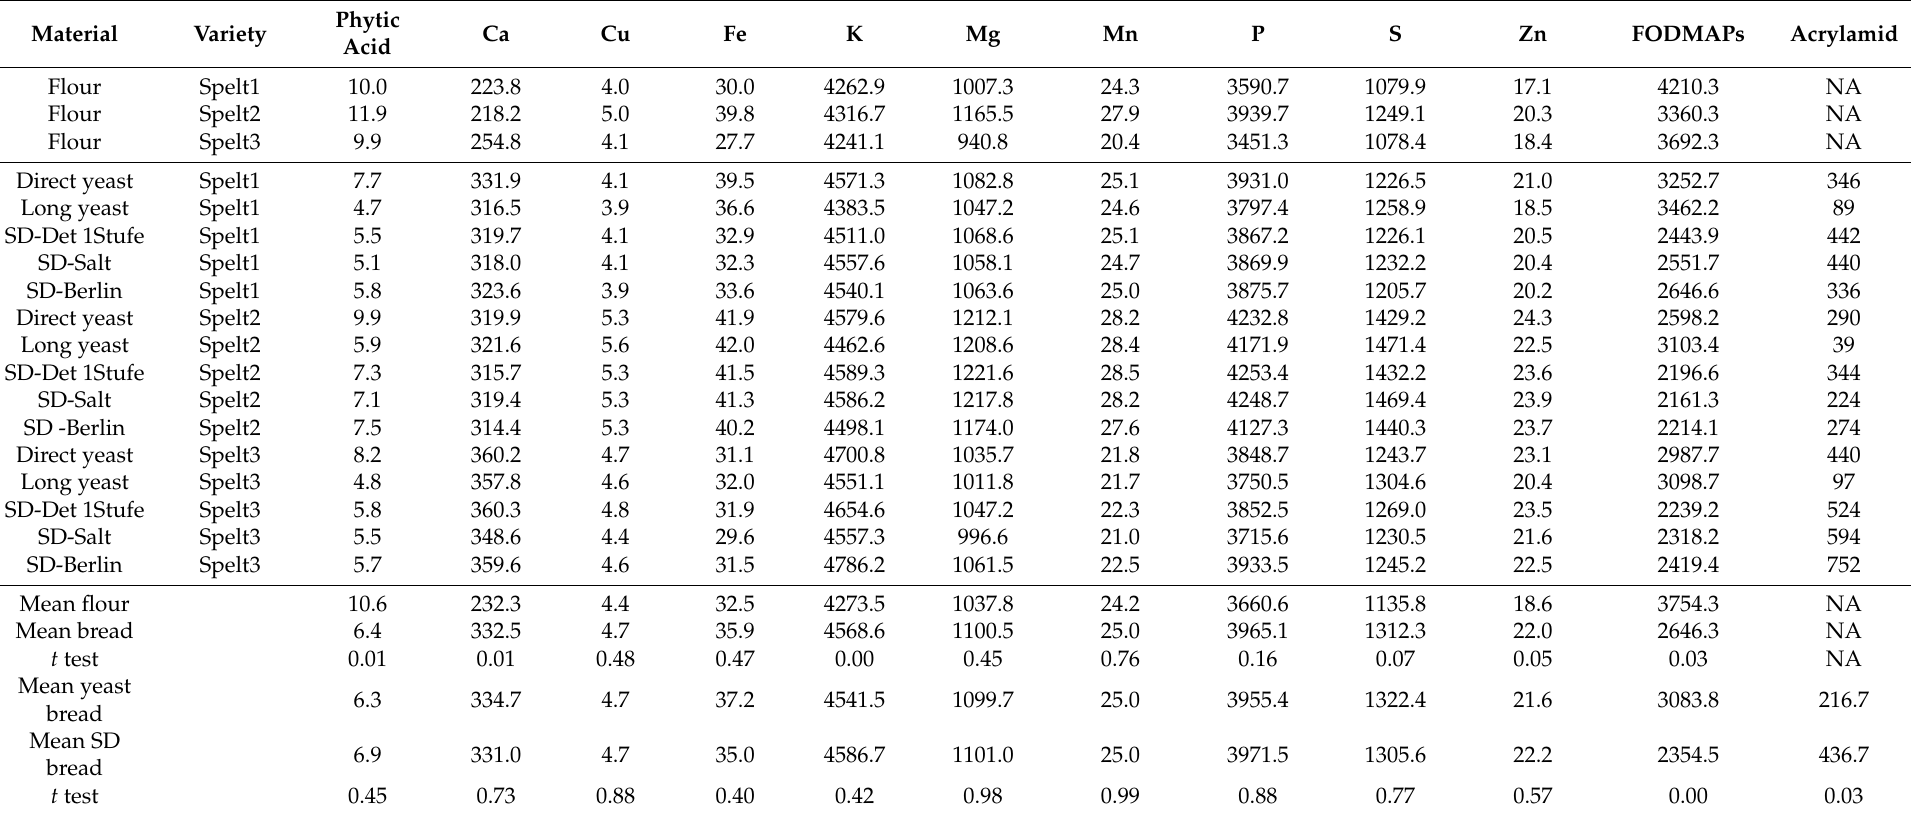
Table 1. Contents of phytic acid ( µ mol/g), minerals (mg/kg) and FODMAPs (mg/100 g) in whole grain flours and breads baked from flours of three spelt varieties (trial series 3) as well as acrylamide in bread crusts ( µ g/kg; trial series 3; SD-Det1Stage = Detmolder 1 stage sourdough, SD-Salt = Monheim salty sourdough, SD-Berlin = Berlin short